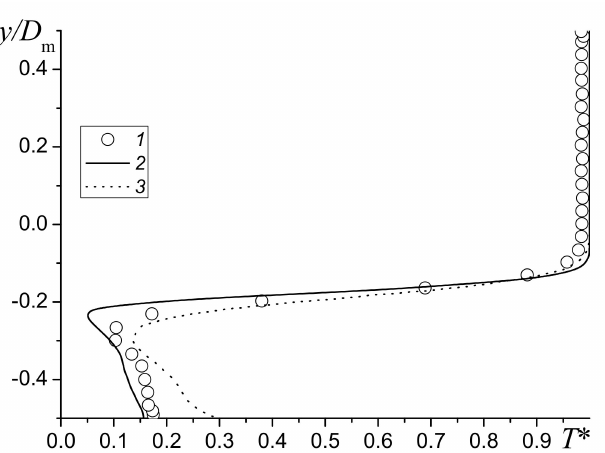
Figure 5. Distribution of the dimensionless temperature T * in the section at the distance z = 0.5 D m behind the socket center at Re m /Re b = 5.76: ( 1 ) WATLON data [10]; ( 2 ) RANS; ( 3 ) LES